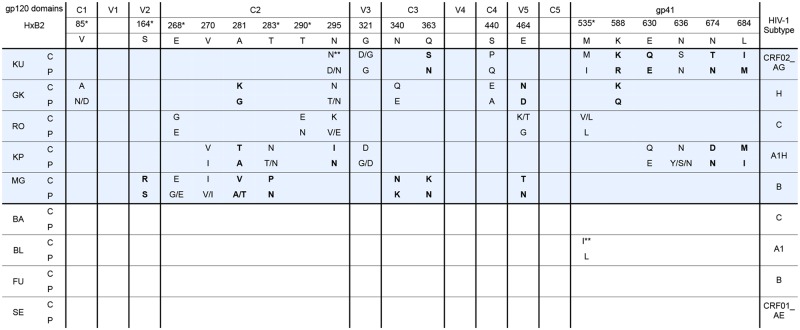
Sites identified as possibly involved in compartmentalization.Dominant amino acids (AA) at positions with statistically significant difference between CSF (C) and plasma (P) for at least 2 subjects or at position previously reported (*) are shown (p < 0.05). In bold, AA that met Bonferroni adjusted statistical significance. These positions were identified only in patients with compartmentalization (highlighted in blue). HxB2 gp160 numbering is indicated. (**) Differences observed at a position shared by several patients but below the significance threshold.